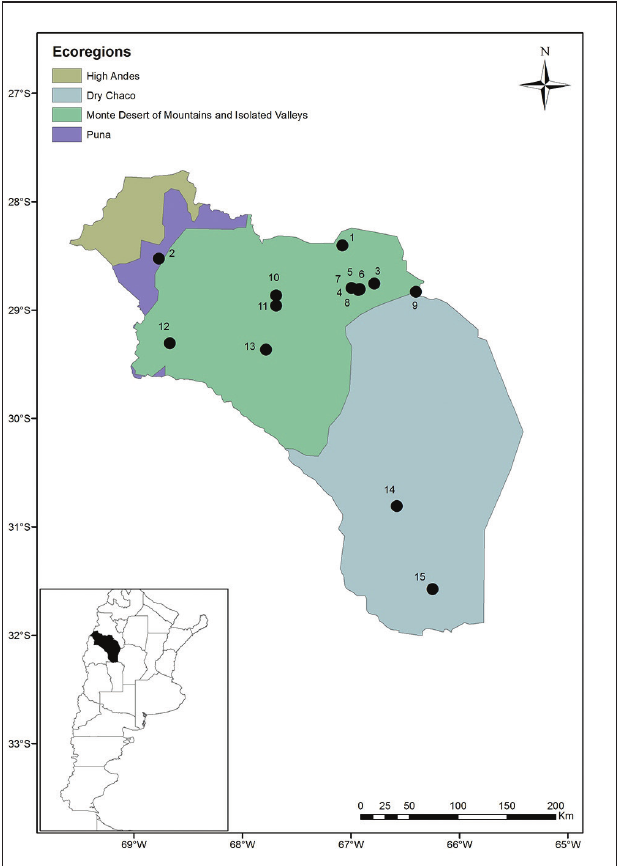
Figure 1. Map illustrating the localities of fleas of bats and rodents from La Rioja Province, Argentina. The symbol with associated locality number are listed on map by latitude from north to south. The lo- calities include specific locality, coordinates, department, and altitudes as follow: 1 700 m E of National Route 40 (28°24'17.4"S, 67°04'48.4"W), San Blas Department, 1123 m 2 Quebrada de Santo Domingo 30 km SW of Jagüé (28°31'34.7"S, 68°46'13.8"W), Vinchina Department, 3131 m 3 2 km S Río de La Punta on provincial road 7 (28°45'28.8"S; 66°47'09.3"W), Arauco Department, 996 m 4 Reserva Aguada de las Alturas, 4 km W Anillaco (28°47.942'S, 66°59.749'W), Castro Barros Department, 1188 m 5 Anillaco, 500 m W of plaza de Anillaco (28°48'40.30"S, 66°55'55.55"W), Castro Barros Depart- ment, 500 m 6 Anillaco 1.7 m E of CRILAR (28°48'46.00"S, 66°55'50.44"W), Castro Barros Depart- ment, 1357 m 7 Anillaco, behind cemetery (28°48'49.04"S, 66°56'0.75"W), Castro Barros Department, 1365 m 8 800 m E Anillaco (28°48.572’ S; 66°55.193’ W), Castro Barros Department, 780 m 9 Cuesta La Cébila, 22 km NW of Chumbicha, by route 60 (28°50'S, 66°24'W), Capital Department: 1066 m 10 5 km S of Cañón del Ocre (28°51'55.9"S, 67°41'26.3"W), Famatina Department, 2495 m 11 8 km NE of Cañón del Ocre, (28°57'37.3"S, 67°41'26.3"W), Famatina Department, 3127 m 12 Zapallar, (29°18'24.74"S, 68°40'9.2"W), Coronel Felipe Varela Department, 1634 m 13 1 km N Los Tambillos (29°22'S, 67°47'W), Coronel Felipe Varela Department, 1951 m 14 2 km E of Malanzán, camping El Descanso (30°48'37.7’”S, 66°34'40.3"W), General Facundo J. Quiroga Department, 957 m 15 Ulapes, 1 km W of plaza principal de Ulapes (31°34'35"S, 66°14'55"W), San Martín Department, 493